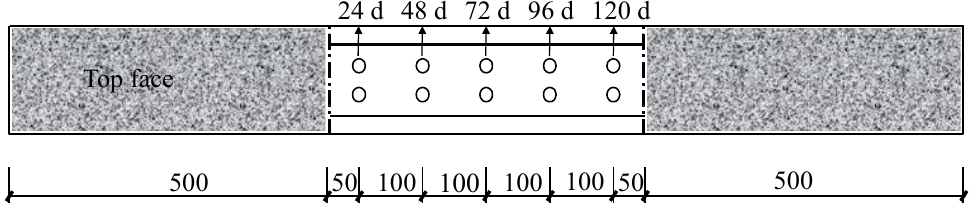
Figure 5. The sampling locations on the specimens used to determine the carbonation depth (mm).